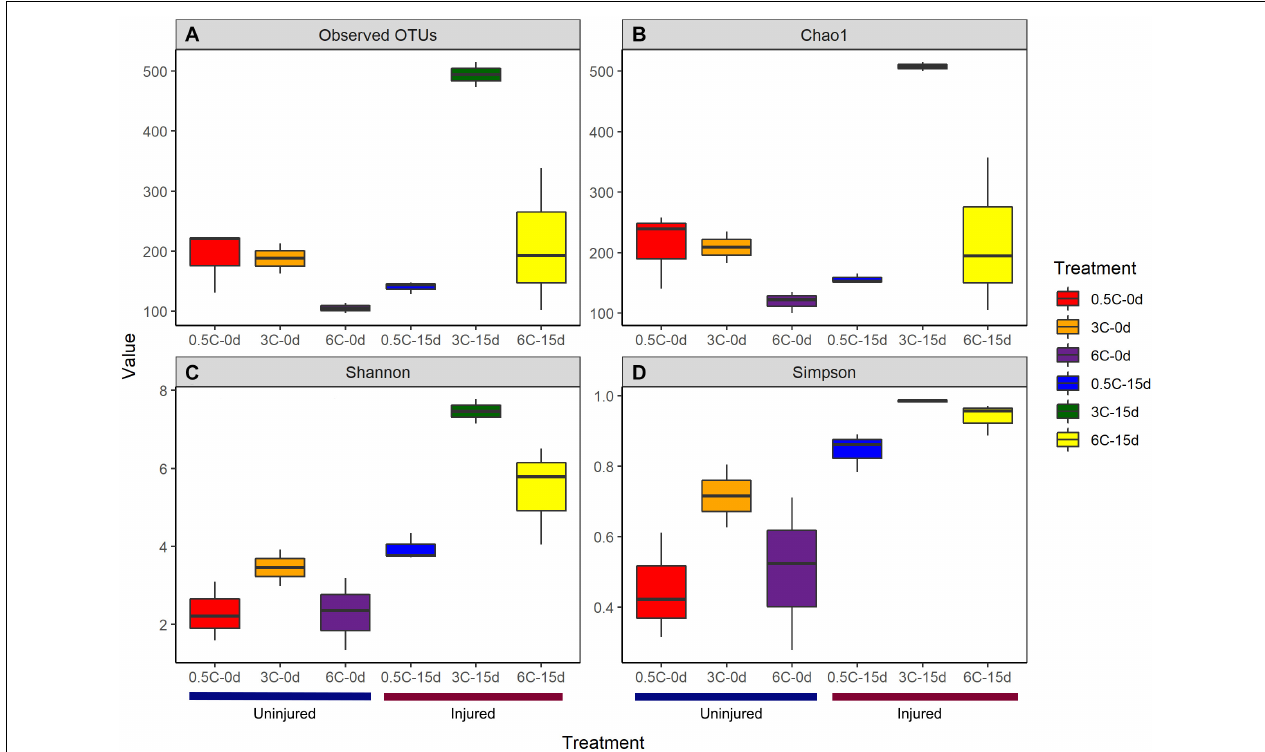
FIGURE 2 | (A) Observed OTU richness (Sobs) (B) Estimated OTU richness (Chao1) (C) Simpson (D) Shannon diversity indices of the prokaryotic communities associated with specimens of Isodictya kerguelenensis exposed to different experimental conditions.